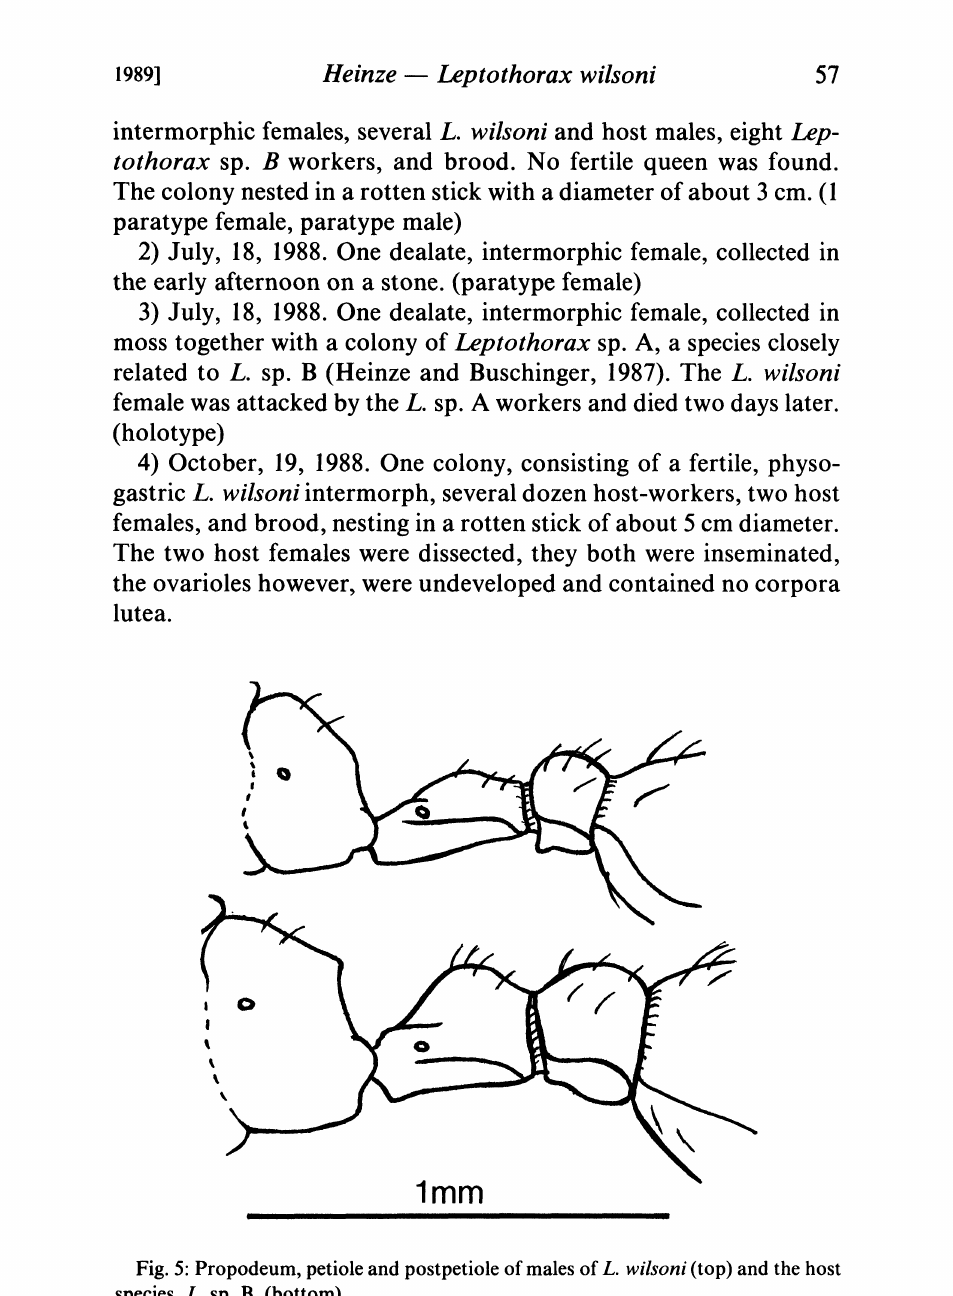
Fig. 5: Propodeum, petiole and postpetiole of males of L. wilsoni (top) and the host species, L. sp. B.